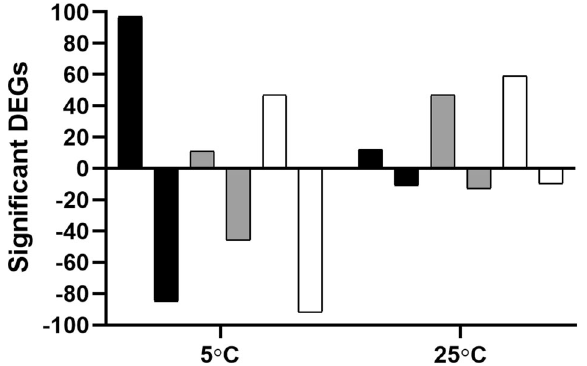
Fig. 2 Gene regulation of Campylobacter jejuni post-exposure to chlorine or ASC. A single C. jejuni isolate was exposed to ASC or chlorine at either 5 or 25 °C and the RNA obtained was processed for RNA sequencing. The number of signi fi cantly regulated bacterial genes following exposure to chlorine (black) or ASC (gray) was computed by using C. jejuni exposed to 0.9% saline as a reference